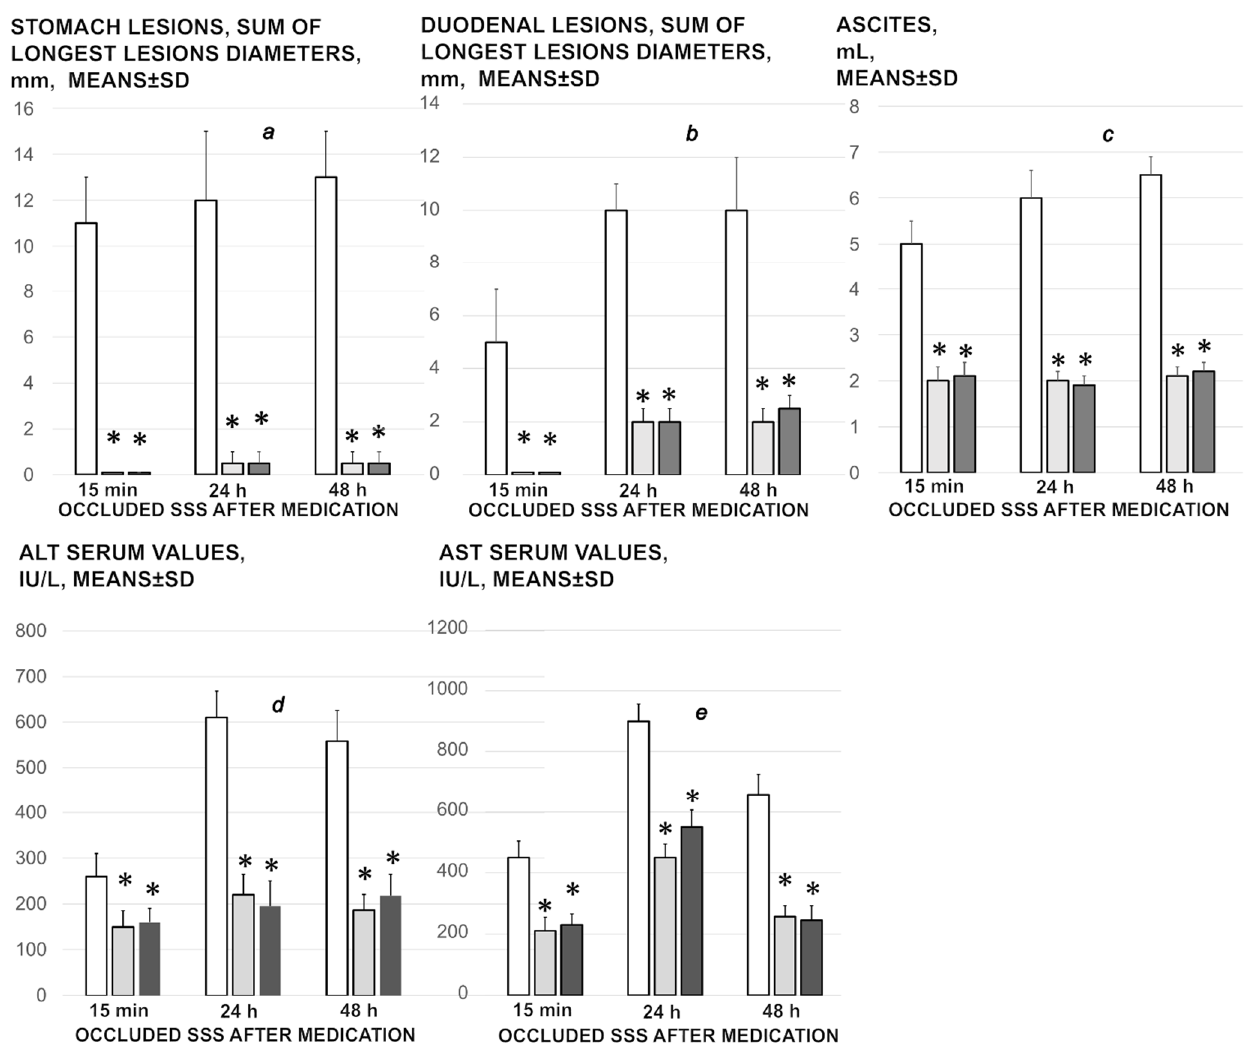
Figure 8. Stomach ( a ) and duodenal ( b ) lesions, ascites ( c ), ALT ( d ) and AST ( e ) serum values presentation in the rats with occluded superior sagittal sinus, after therapy at 15 min, 24 h, and 48 h ligation-time. Therapy was saline 5 mL/kg (white bars), BPC 157 10 µg/kg (light gray bars), 10 ng/kg (dark gray bars) given intragastrically at 1 min ligation-time while the effects of the intraperitoneal and local application regimen, providing the similar results were not specifically shown. Means ± SD, * p < 0.05, at least vs. corresponding control.